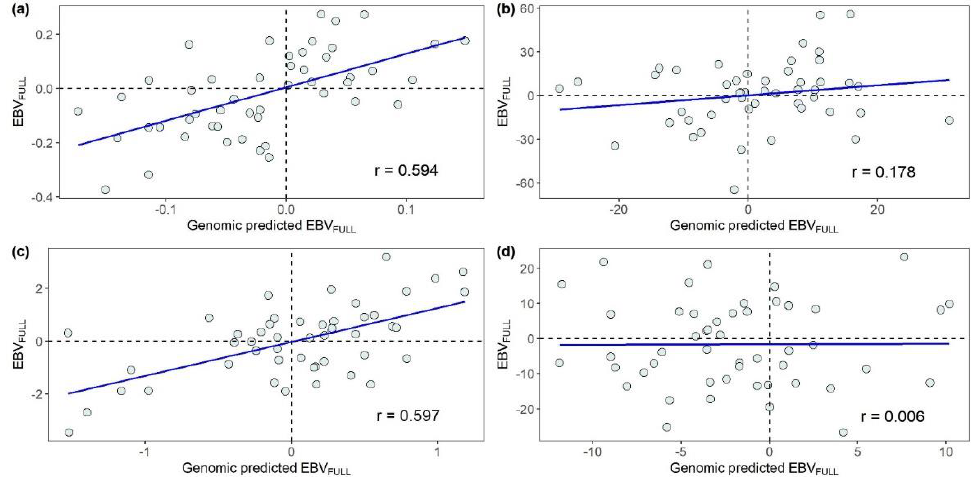
Figure 2. Relationships between the estimated breeding values (EBV FULL ) and their genomic pre- dictions obtained for the parents of the challenge-tested fish in the leave-one-family-out validation procedure: ( a ) mortality, ( b ) body weight, ( c ) square root of serum cortisol concentration and ( d ) anti- body titer. r : Pearson product-moment correlation.